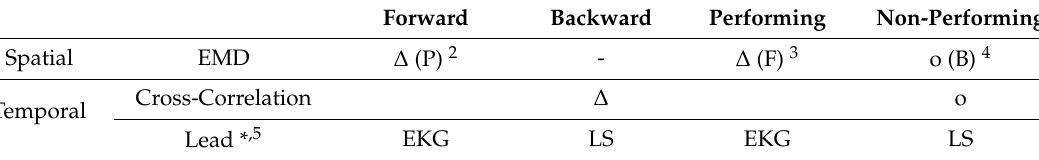
Forward Backward Performing